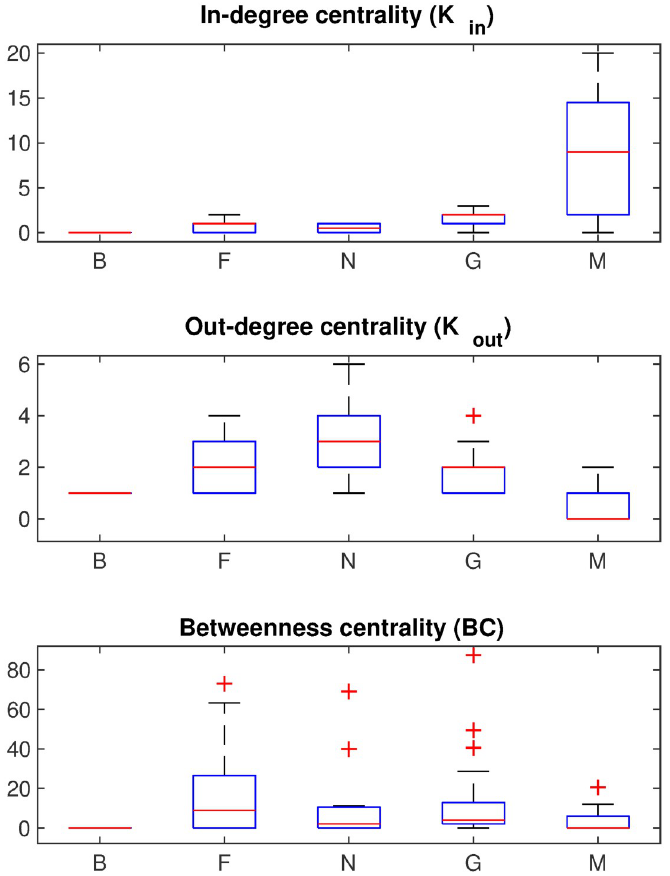
Fig 2. Centrality measures of the generated network. The three set of boxplots show three different centrality measures as marked (In-degree ( K ), Out-degree ( K ), and Betweenness ( BC )). The five different pig operations are in out marked in the horizontal axes as: Boar Stud (B), Farrow (F), Nursery (N), Grower/Finisher (G), and Market/ Slaughterhouse (M). Each boxplot shows the range between 25 th and the 75 th percentiles (blue box) and the median (red line). The values outside 1.5 times the inter-quartile range are marked as outliers (+